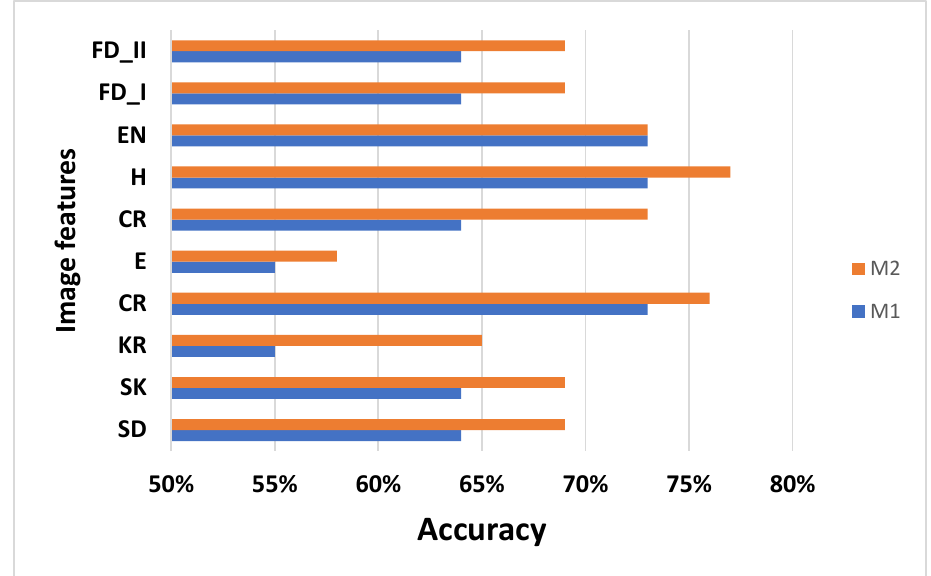
Figure 5. Performances for M1 and M2 methods obtained with SVM.